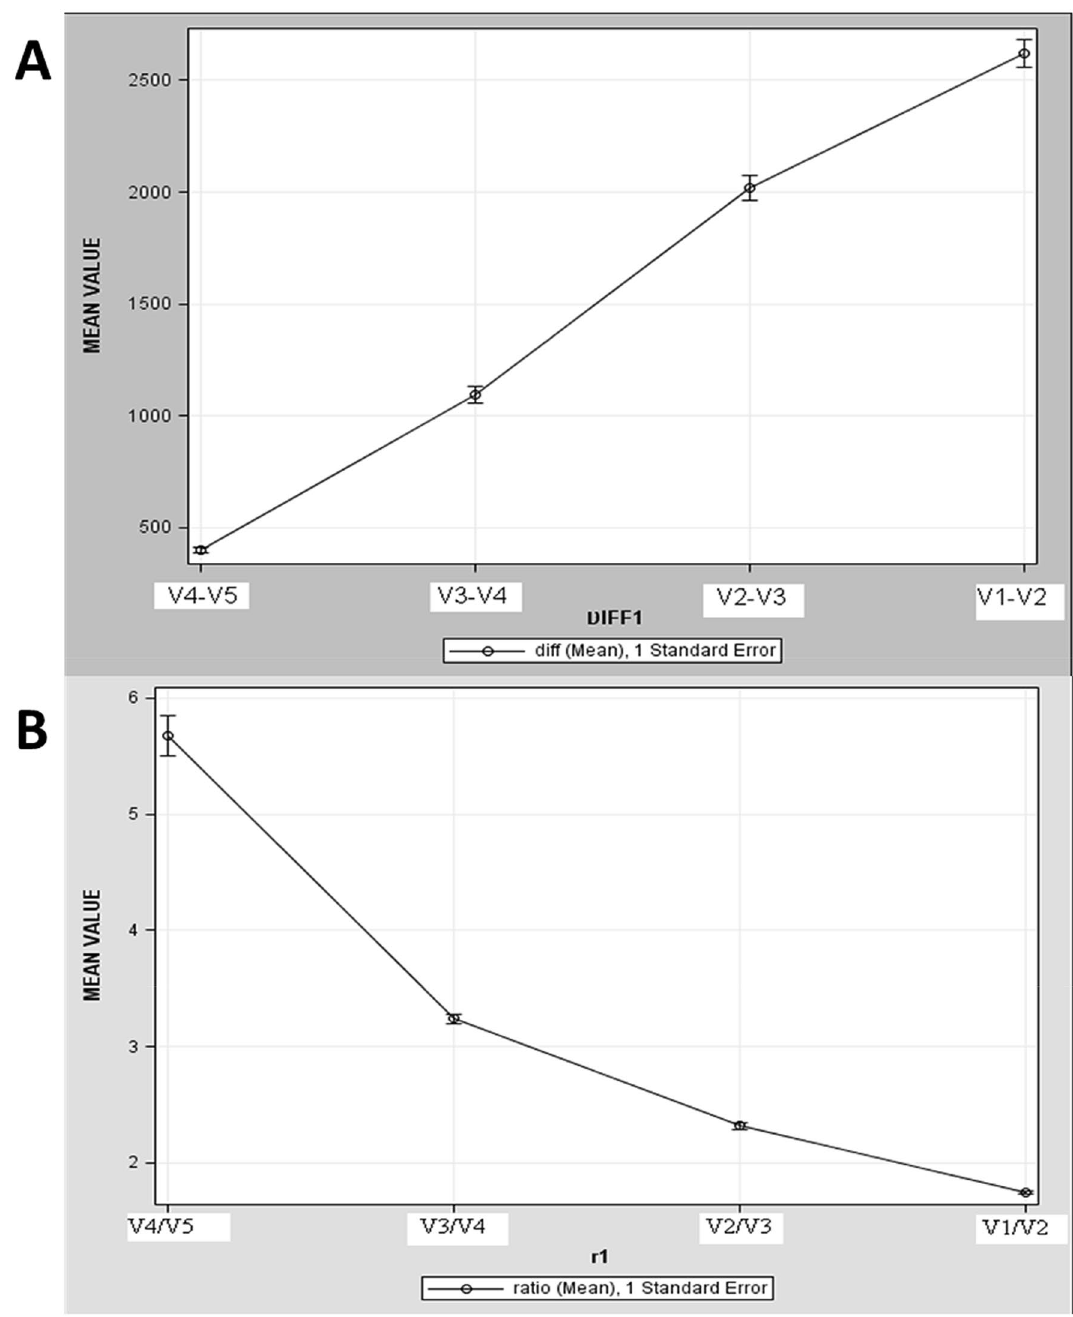
Figure 2. Orbital apex calculations and comparison. ( A ) The subtraction of differences in orbital volumes. The X axis – represents points of calculated differences between retrobulbar orbital volumes, they are shown at an equal distance from each other. The Y axis—represents the subtraction differences in nearest retrobulbar orbital volumes in mm 3 . Progression of a decline is most obvious between retrobulbar orbital volumes V2-V3 and V3-V4. ( B ) The X axis – represents points of calculated ratio differences between retrobulbar orbital volumes, they are shown at an equal distance from each other. The Y axis—represents ratio differences in the nearest retrobulbar orbital volumes. ProgressionSteeper progression of a decline is most obvious between V4/V3 and the most dramatic decline in the volumes occursis observed at the ratio between V4/V3 and